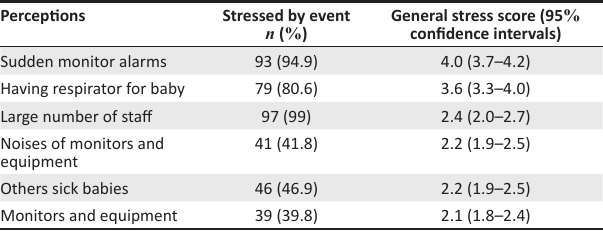
TABLE 4: Parents’ perceptions of staff factors causing stress ( n =